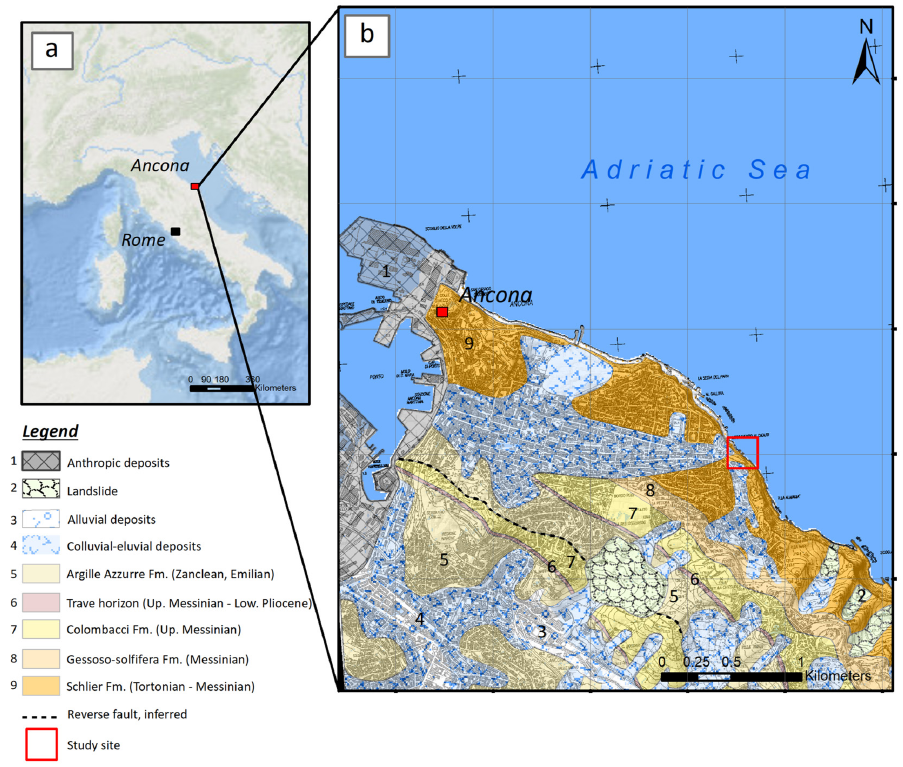
Figure 1. Geographical ( a ) and geological framework of the study area, with indication of the study site ( b